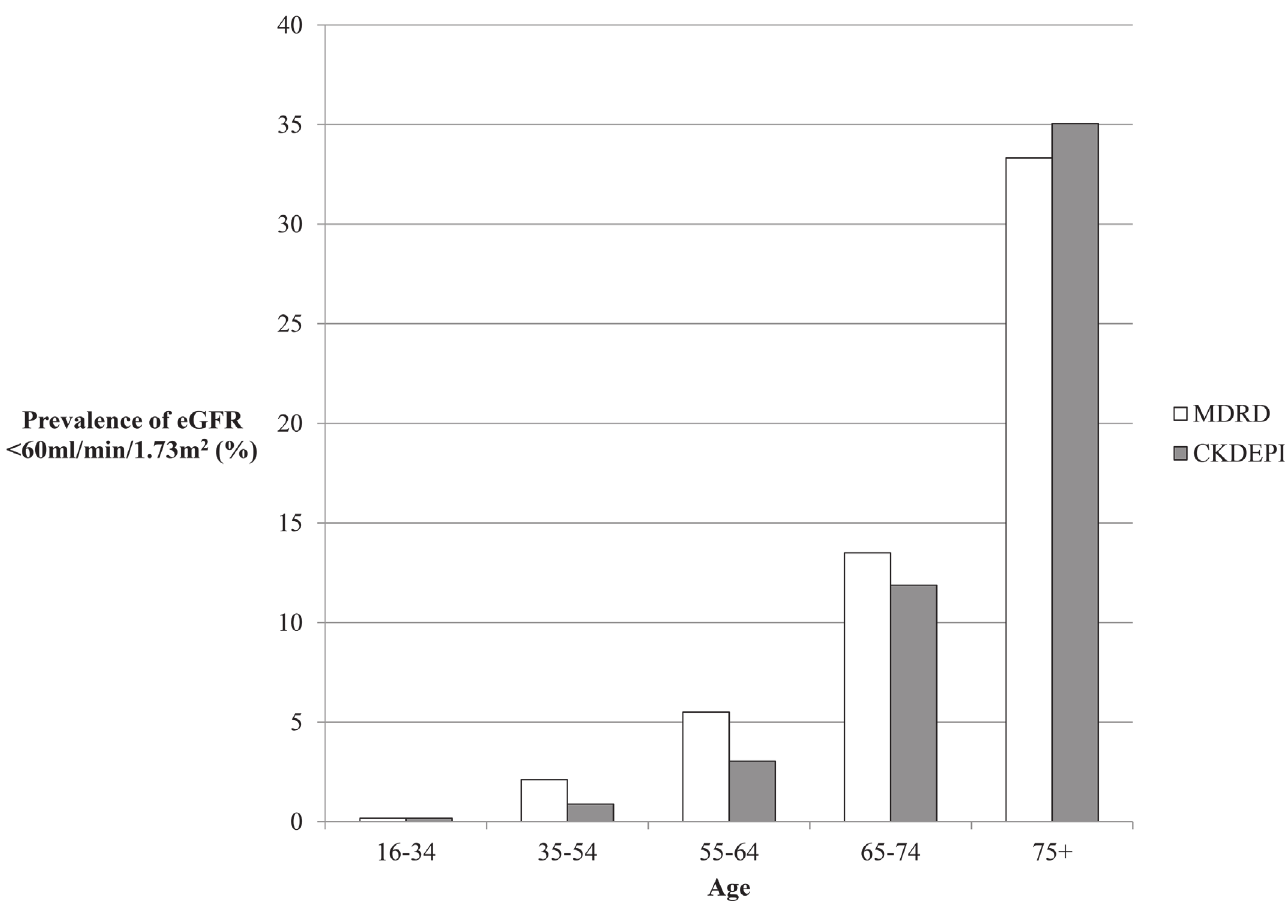
Fig 1. Prevalence of eGFR < 60ml/min/1.73m 2 by age grouping and serum creatinine eGFR estimating